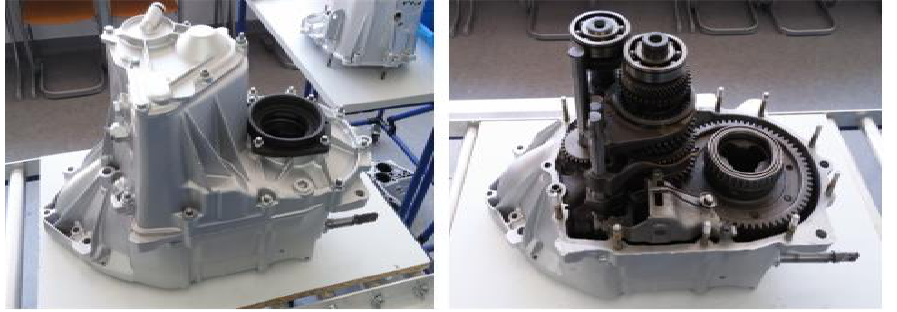
Figure 2. The assembled manual gearbox in LLF.